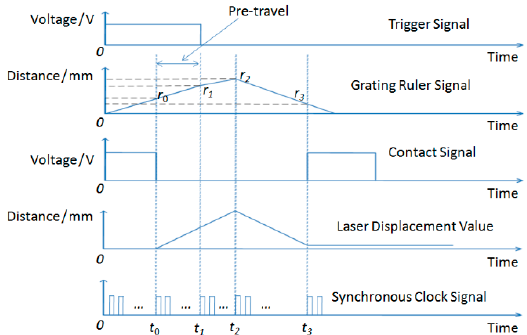
Figure 4. Measurement time sequence diagram of the calibration system.